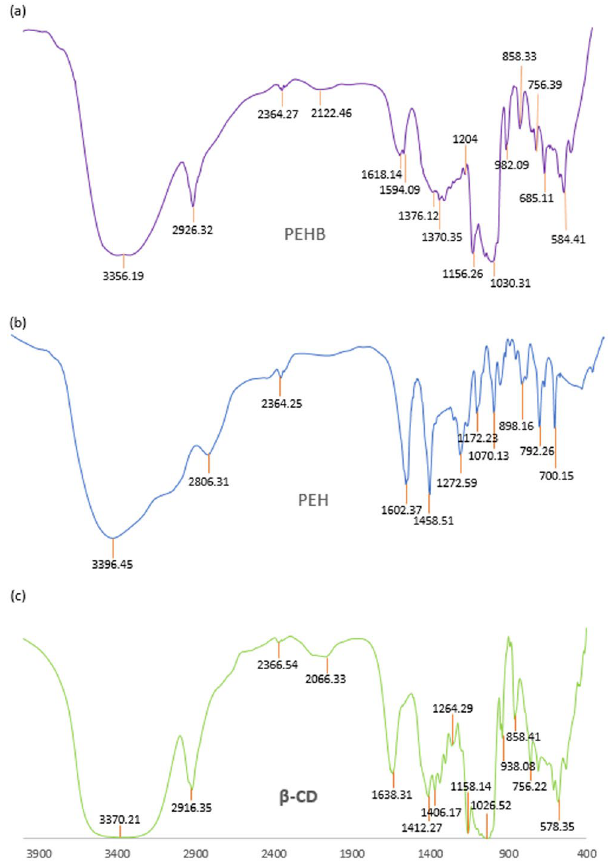
Figure 16. (a , b , c) FTIR spectra of (a) PEH + β -CD, (b) PEH, (c) β